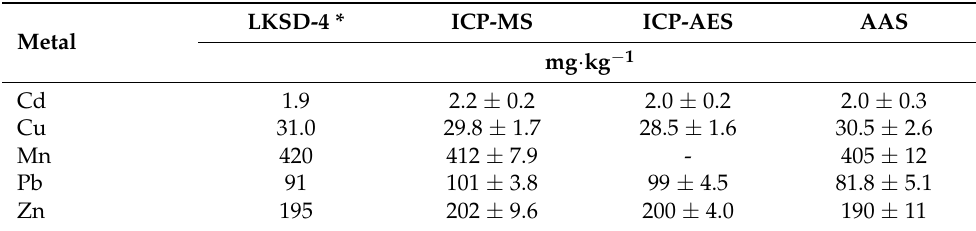
Table 1. Concentrations of selected metals in the LKSD-4 reference material, determined using different instrumental methods